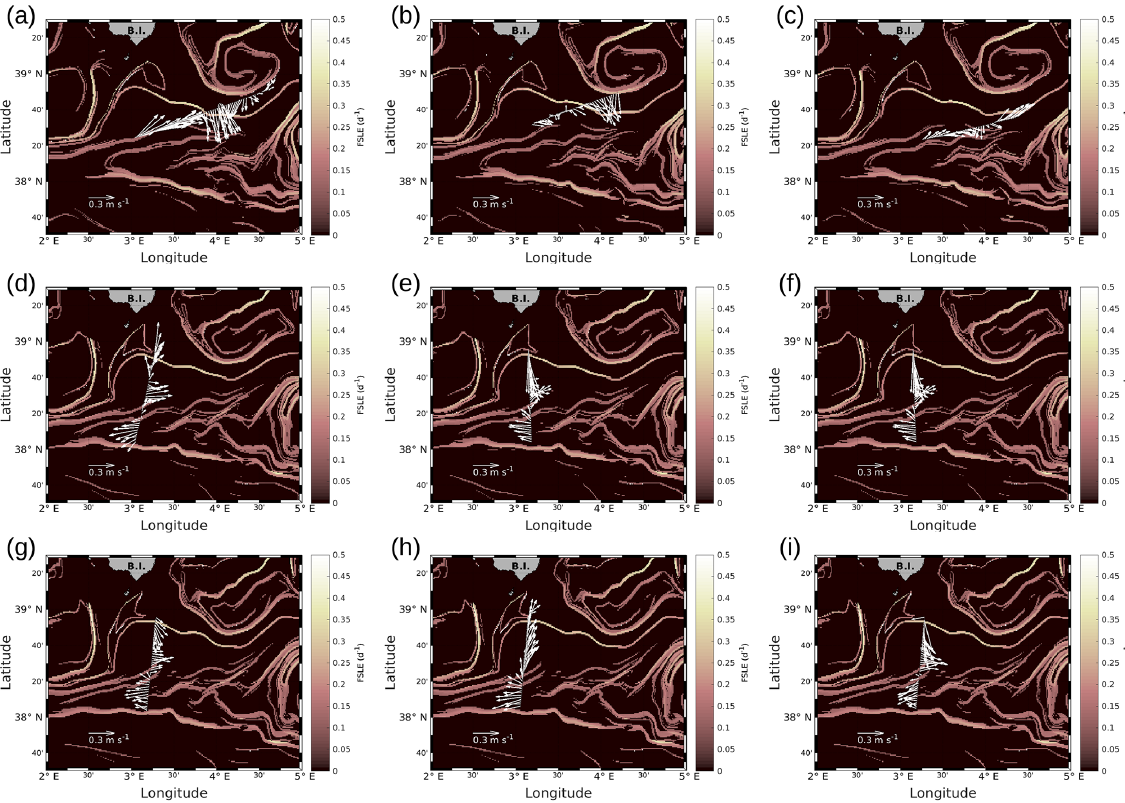
Figure A2. Horizontal velocities measured by VMADCP, along transects of the WE hippodrome (a–c) and the NS hippodrome (d–i) : (a) 8 May at 12:50–9 May at 00:30; (b) 9 May at 09:00–9 May at 15:30; (c) 9 May at 16:50–9 May at 23:45; (d) 11 May at 02:00–11 May at 08:40; (e) 11 May at 10:00–11 May at 16:45; (f) 11 May at 17:55–12 May at 00:50; (g) 12 May at 01:50–12 May at 08:20; (h) 12 May at 09:30–12 May at 16:40; (i) 12 May at 17:30–13 May at 00:20. The lines in bold correspond to the WE and the NS transects described in the manuscript and also represented in Fig. 4. In our study, we have chosen to select transect (c) for the WE hippodrome, due to a lack of temperature and salinity data for the other transects of the WE hippodrome, resulting from technical problems with the SeaSoar.